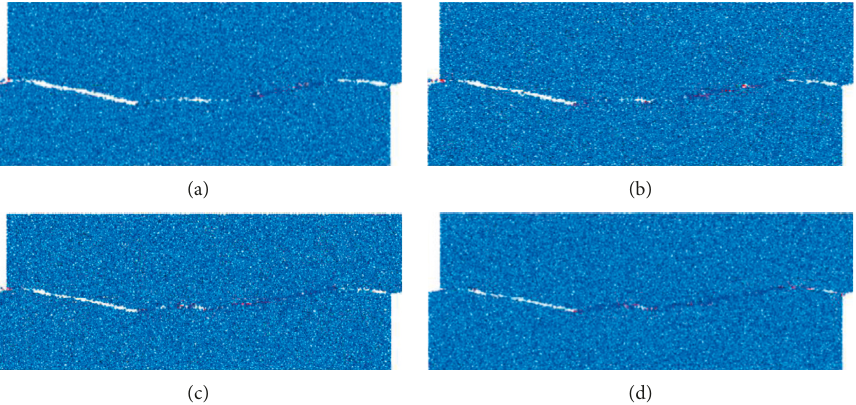
Figure 18: Damage evolution along a joint with a JRC of 10–12 when the shear displacement is 3mm (red dots indicate the fracture location). Normal displacement: (a) 1MPa; (b) 2MPa; (c) 3 MPa; (d) 4